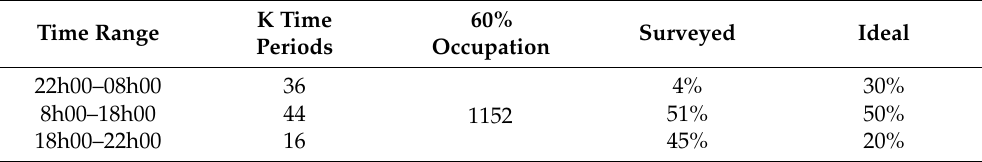
Table 5. Scenario with 60% occupation of the charging